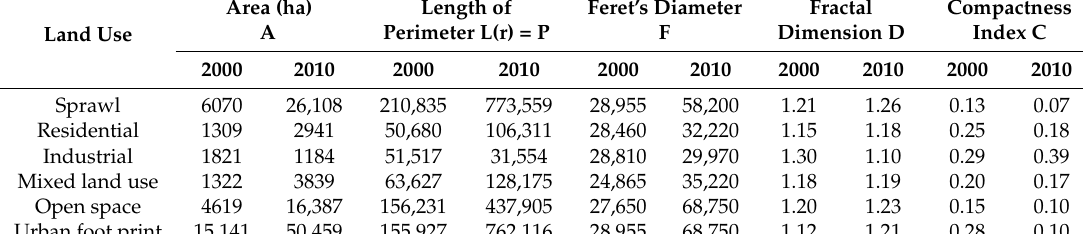
Table 5. Characteristics of urban land use.